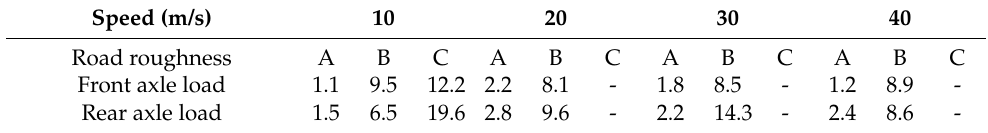
Table 5. The relative error (%) of moving load identification from sensor placement S7.